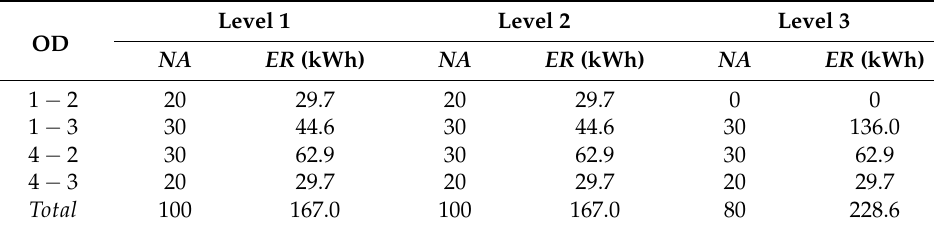
Table 9. Comparison of the charging station construction programs